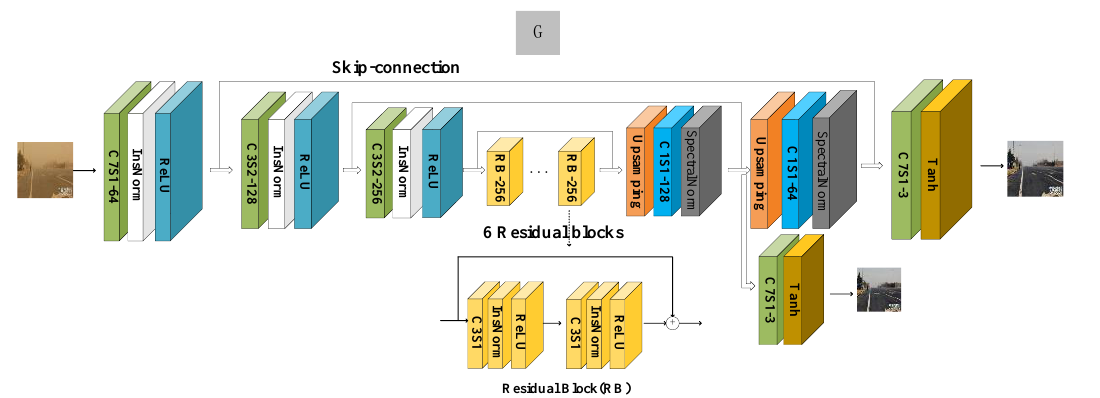
Figure 3. The proposed generator structure. Here, C7S1-64 denotes a convolutional layer with a kernel size of 7, channel number of 64, and stride of 1. kernel size of 7, channel number of 64, and stride of 1.